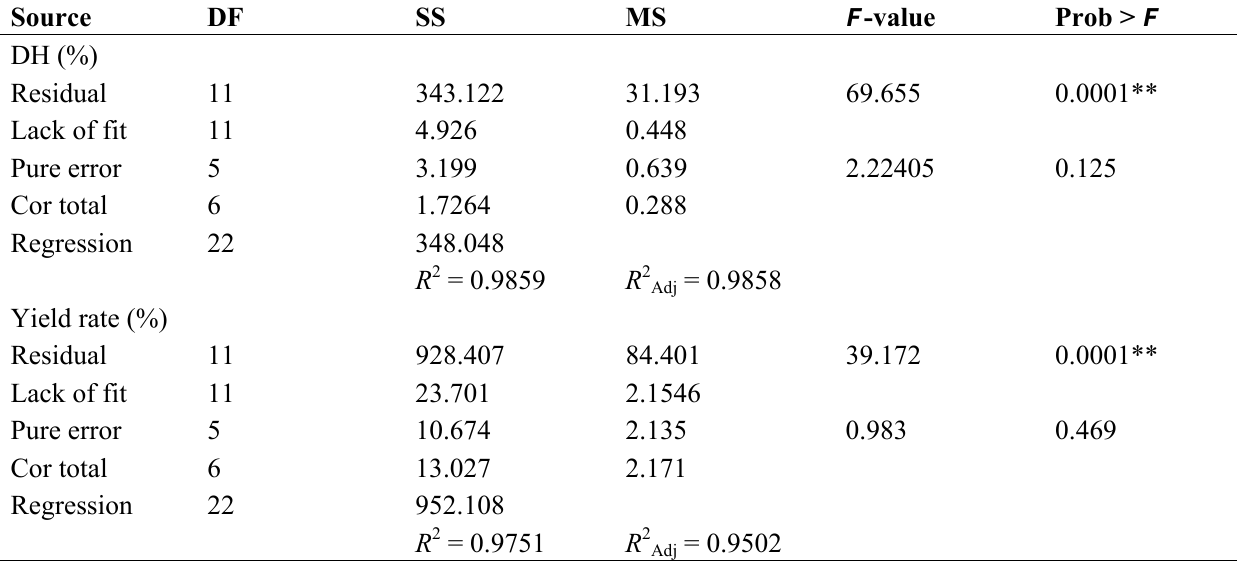
Table 2. The analysis of variance (ANOVA) for the fitted quadratic polynomial model of DH and AOP yield rate.